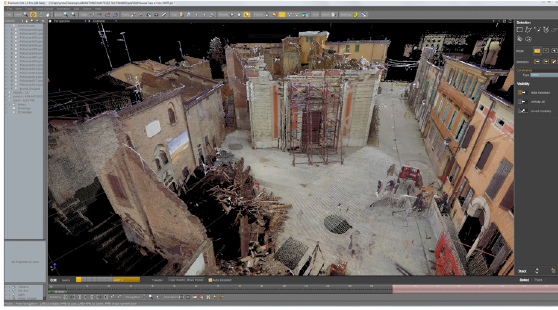
Figure 6: Registered point